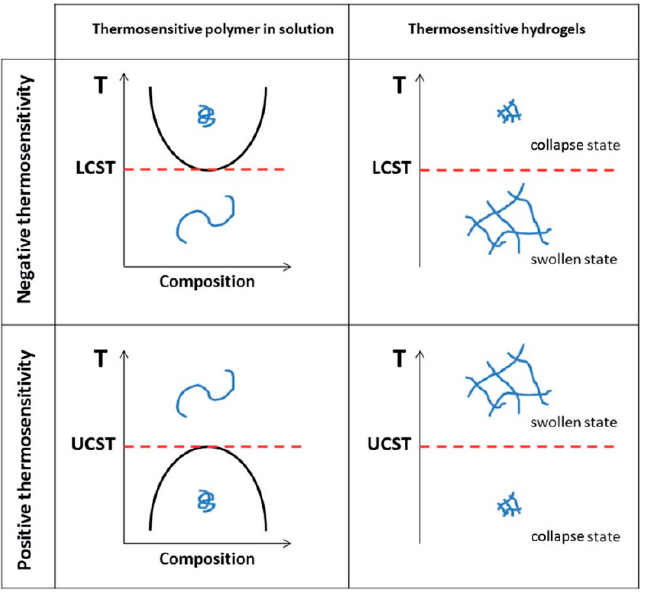
Figure 1. Thermosensitive behaviors of polymers in solution and hydrogels [13]. Compared with the C-UCST polymers, of which the UCST in water lower than 100 ◦ C and the interchain associations of the zwitterionic groups were easily destroyed by the salt ions in saline [39], HB-UCST polymers can manipulate the volume transition higher than 100 ◦ C relying on hydrogen bonding and are less sensitive to the salt ions. Among the HB-UCST polymers, hydrophobically modified poly(vinyl alcohol)s (PVA) can possess a UCST in the range of 100~200 ◦ C depending on the modification. One example is partially butyl-functionalized PVAs [33] that samples with butyl contents of 7.6 or 9.6 mol% and